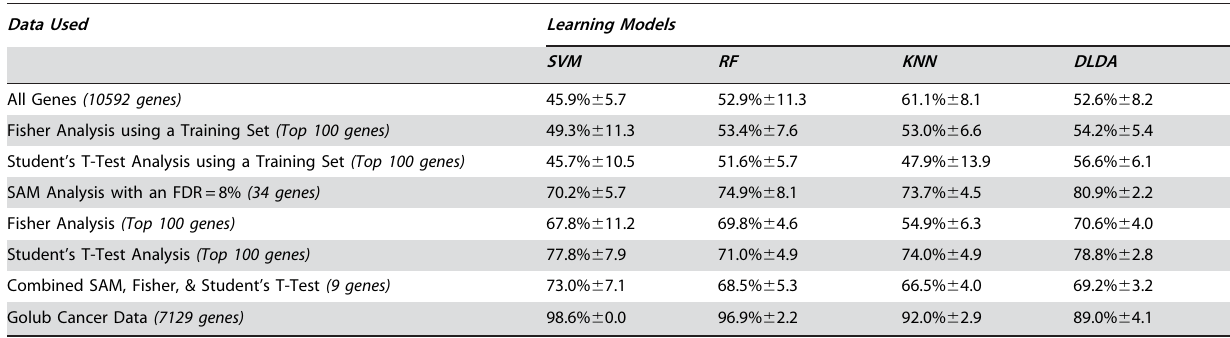
Table 3. Prediction accuracies using ten times 10-fold cross validation with different gene subsets. .. ... .... ... ... .... ... ... .... ... ... .... ... ... .... ... ... .... ... ... .... ... ... .... ... ... .... ... ... .... ... ... .... ... ... .... ... ... .... ... ... .... ... ... .